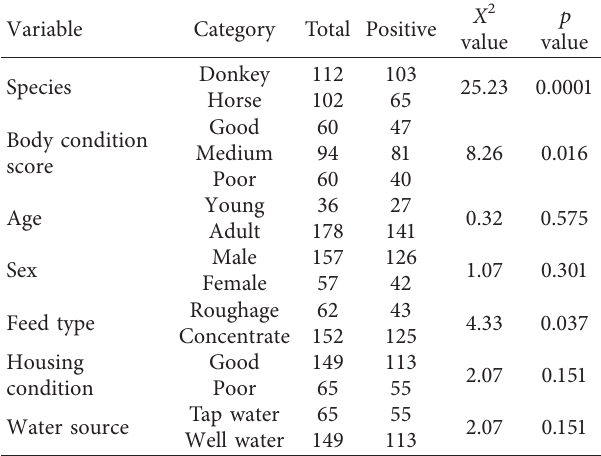
Table 3: Prevalence GI parasites in association with risk factors of